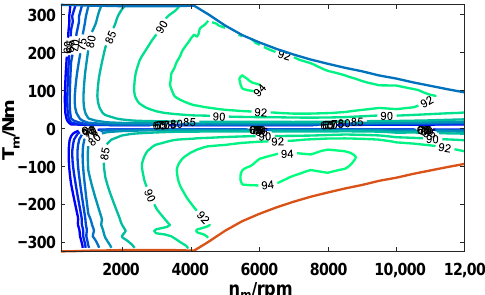
Figure 10. Motor efficiency map.